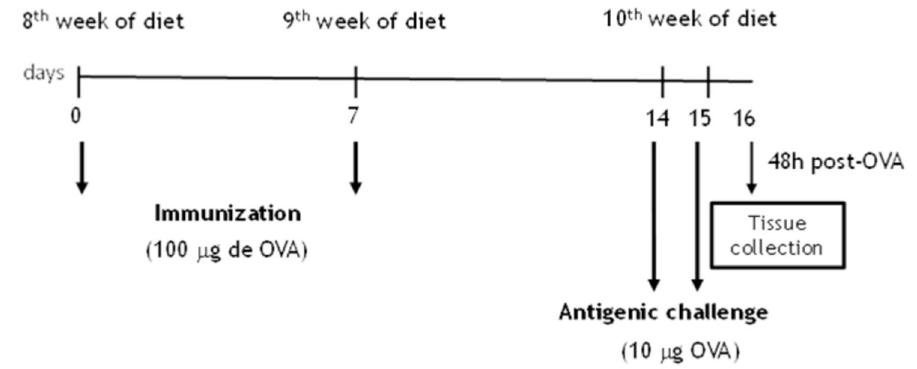
Figure 1. Schematic representation of ovalbumin (OVA) immunizations and challenges. doi: